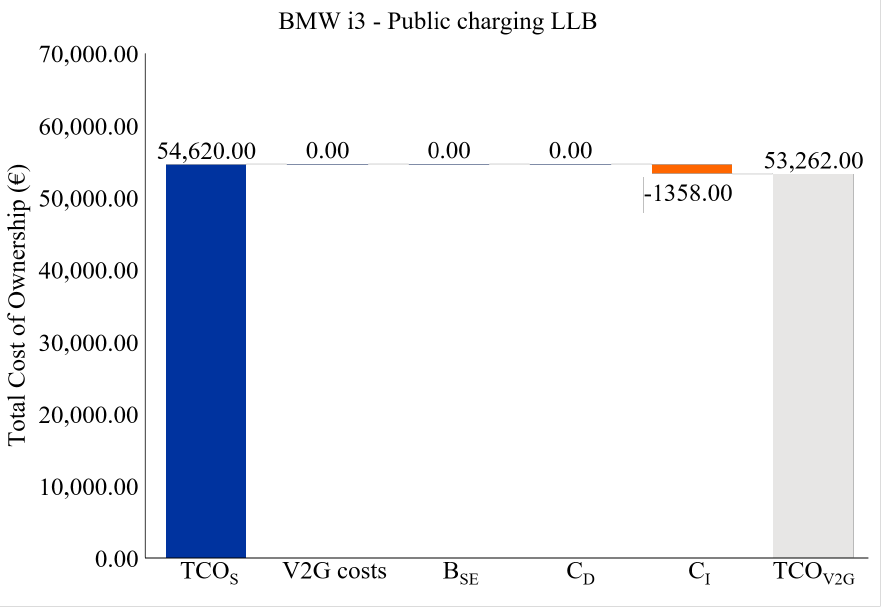
Figure A17. Standard and V2G TCO of a BMW i3 in a public charging case providing LLB ( TCO S = Standard TCO, B SE = benefit of saved electricity costs from the grid, C D = direct com- pensation, C I = indirect compensation, TCO V 2 G = V2G TCO); source: own